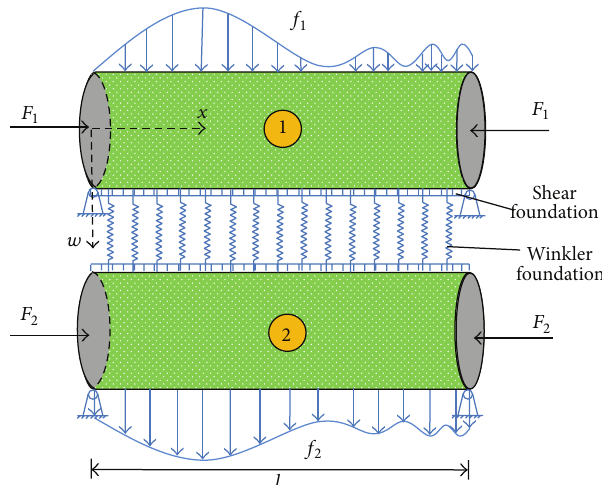
Figure 1: Double single-walled carbon nanotube system.